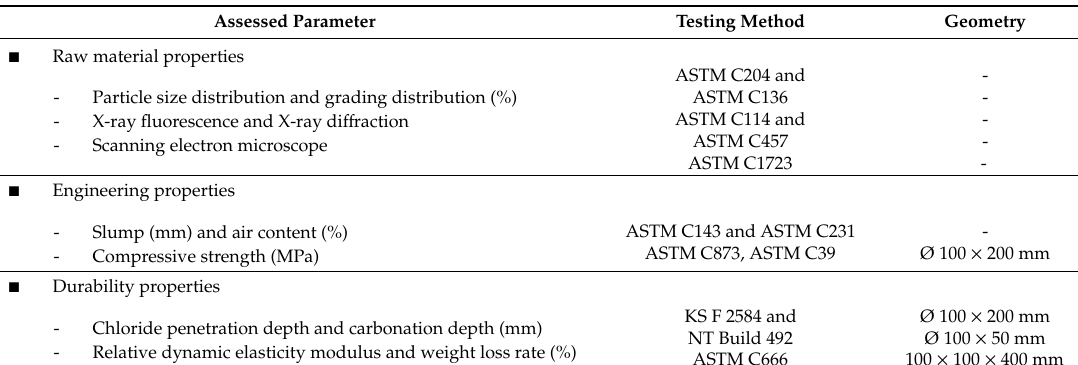
Table 5. Testing methods for the assessed